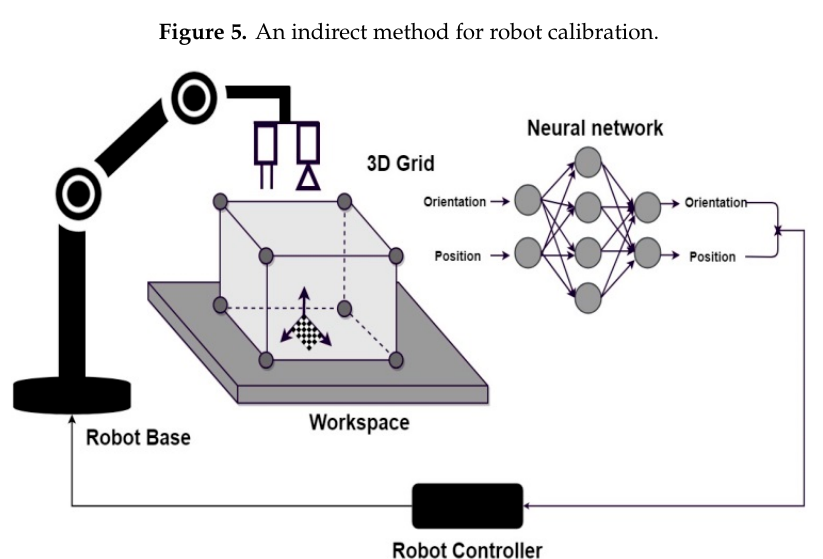
Figure 6. Indirect method for robot error-compensation.